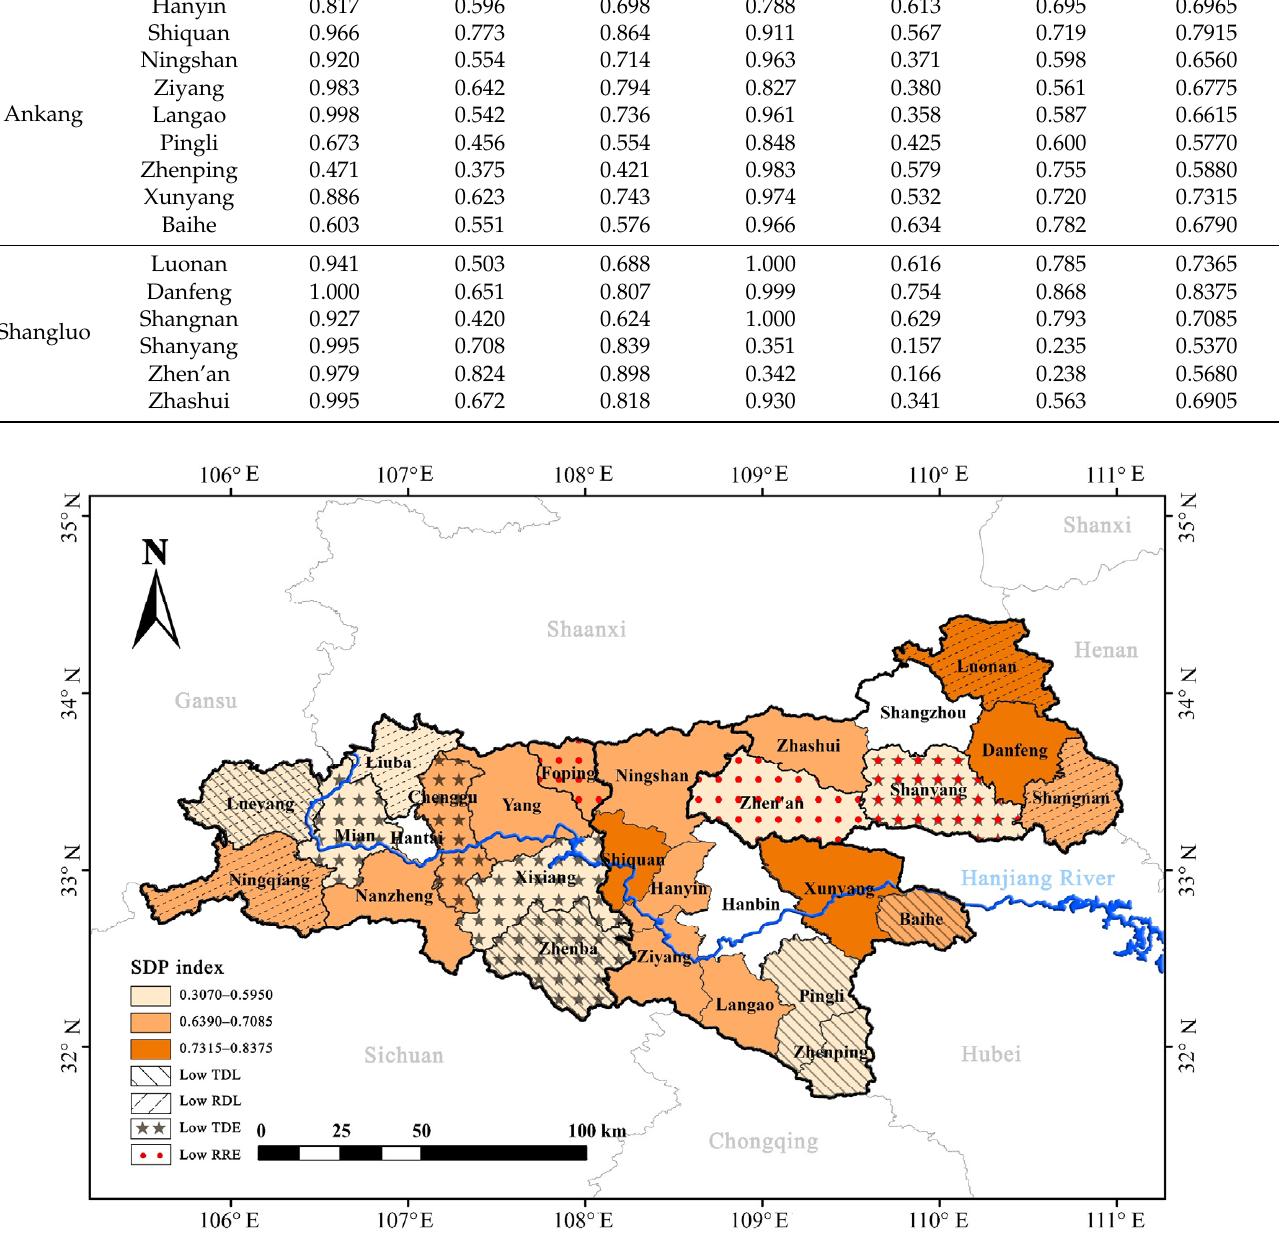
Figure 10. Distribution map of different SDP areas.